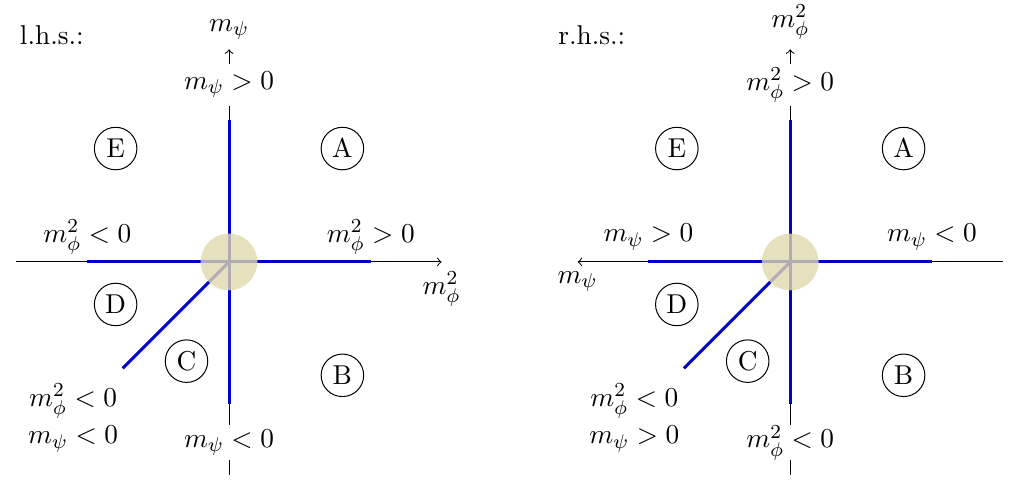
Figure 1 . Masks for the phases of the various dualities. The phases in circles are either fully gapped (possibly with topological order) or contain Goldstone bosons. The thick blue lines correspond to the tuning of one mass parameter that conjecturally yields extra massless matter. The shaded circle in the middle covers the detailed structure of the phase diagram around the origin, which we do not know